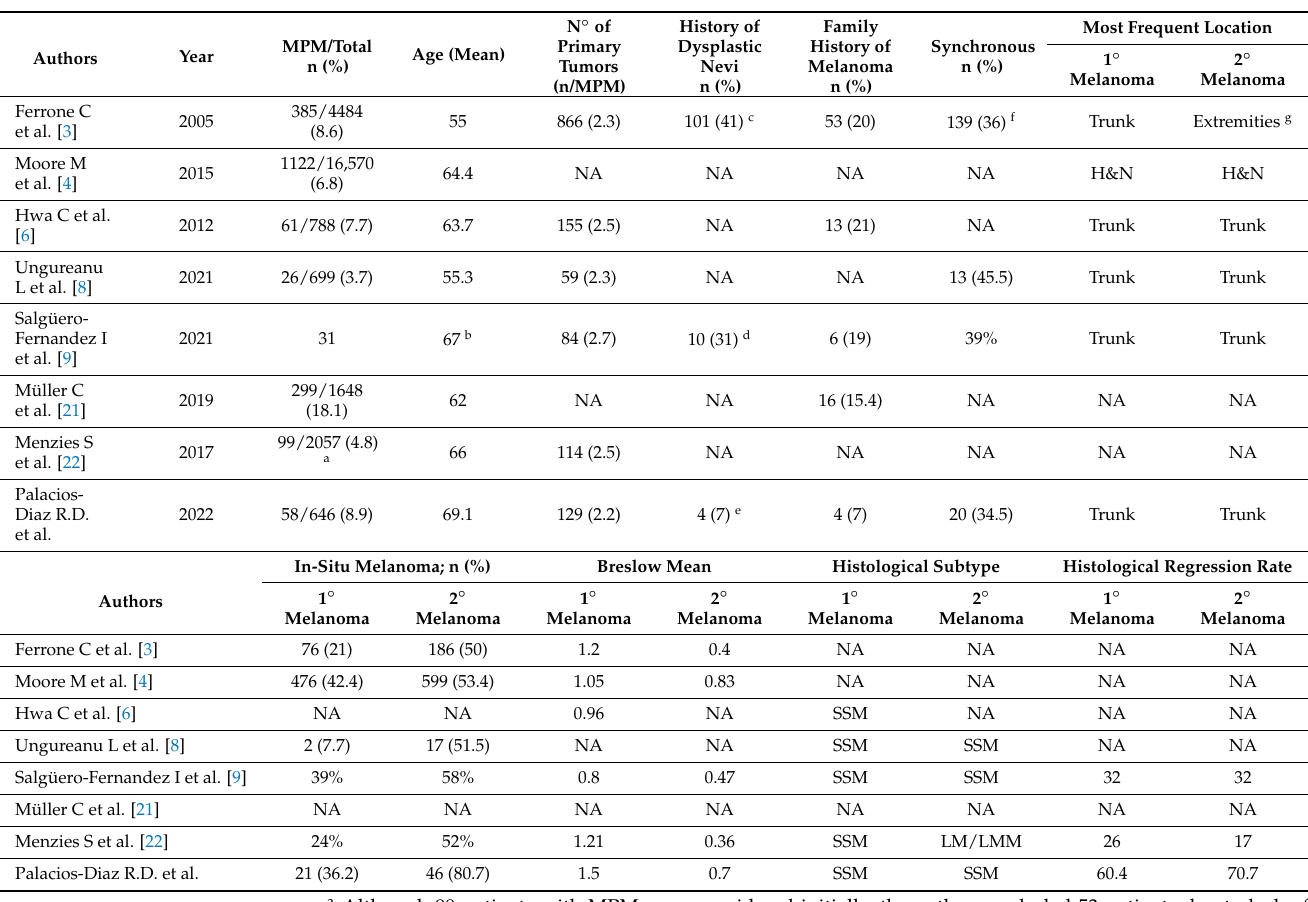
Table 3. Summary of previous